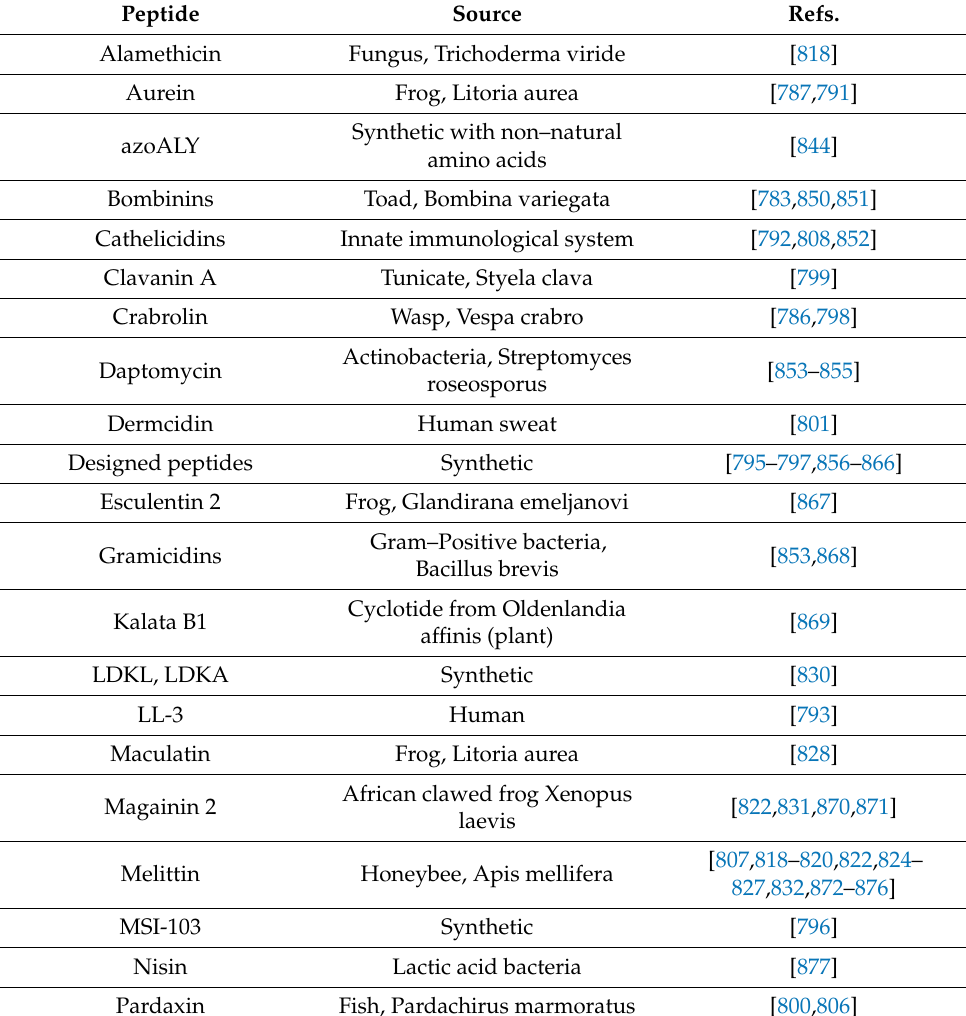
Table 4. Antimicrobial